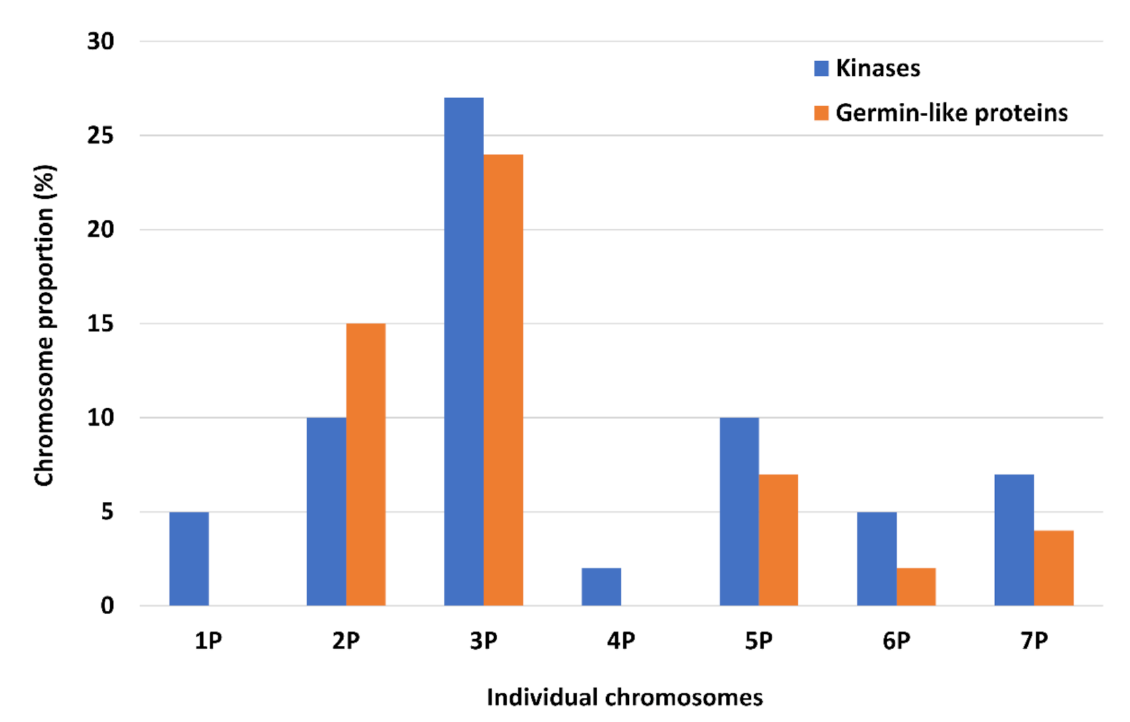
Figure 1. Chromosomal distribution of the two most represented gene functional families observed in the draft sequencing of A. cristatum . X -axis: individual Agropyron chromosomes; Y -axis: chromosome proportion